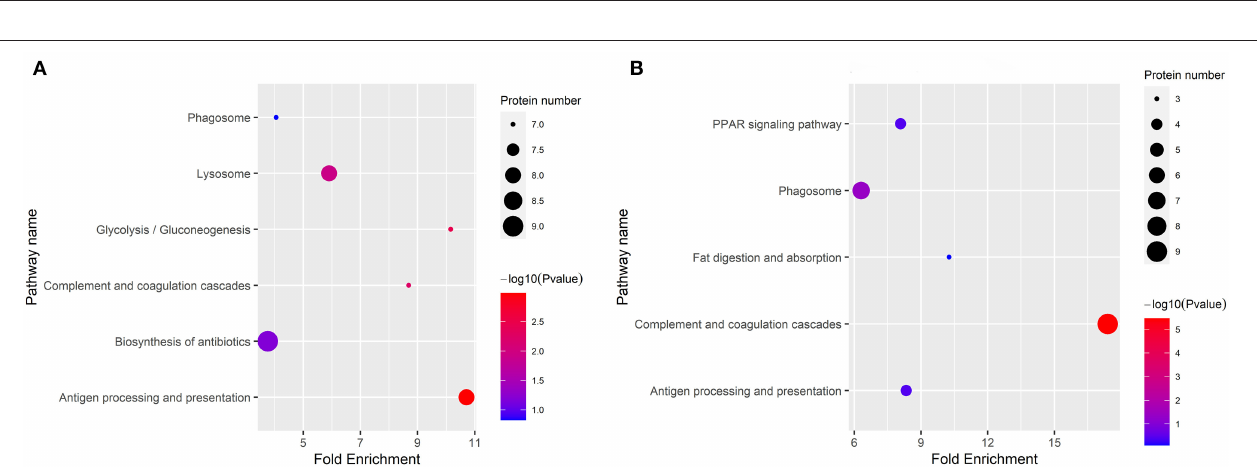
FIGURE 4 | Enriched KEGG pathway analysis of the DEPs in DM vs. CM group (A) and DM vs. HM group (B) . The bubble size indicates the amount of protein enriched into the pathway. The color gradient corresponds to the magnitude of p -value. The gradient becomes red and indicates a small p -value.